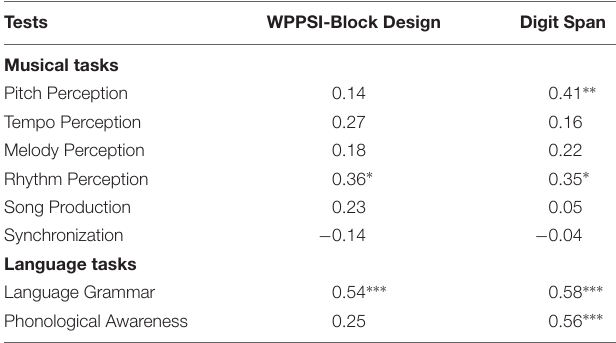
TABLE 4 | Correlations between musical tasks and tests of non-verbal ability (WPPSI-Block Design) and verbal memory (Digit Span).